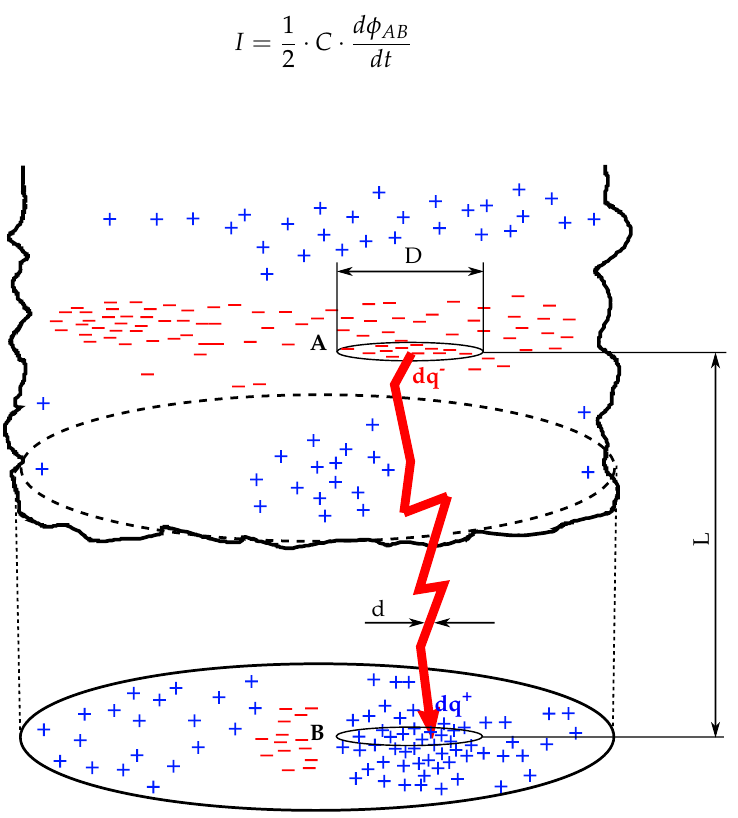
Figure 4. Distribution of